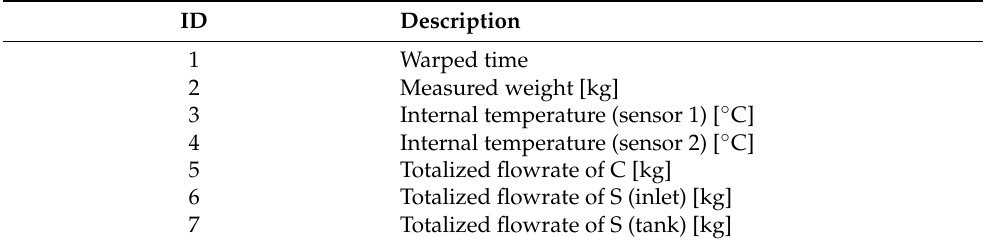
Table A1. List of the process variables analyzed for unit